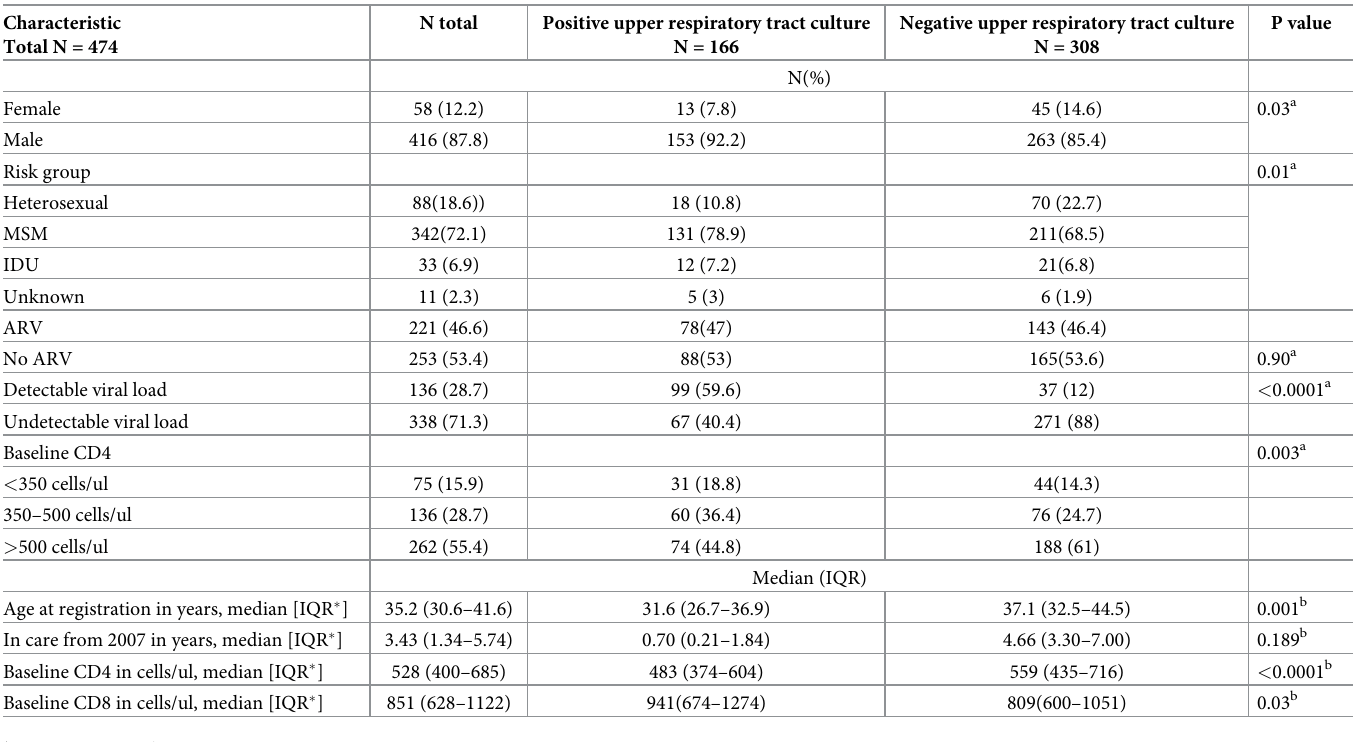
Table 2. Baseline characteristics for the groups of patients with positive and negative upper respiratory tract